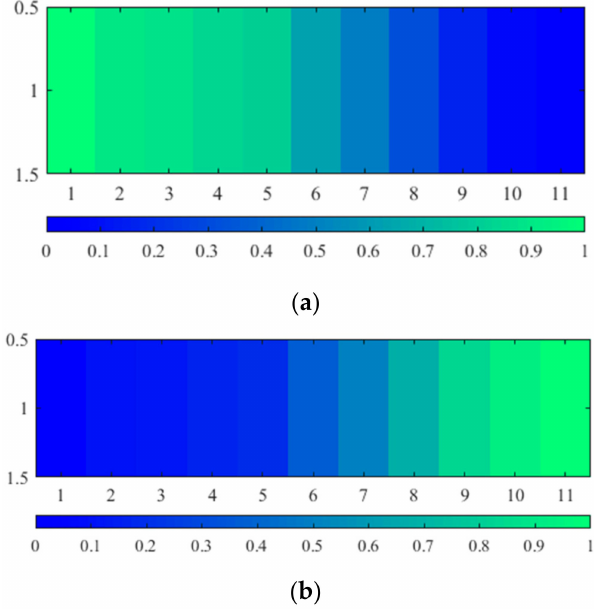
Figure 11. Quantitative distribution diagram of energy density: ( a ) 6 mm side amplitude quantization distribution diagram; ( b ) 10 mm side amplitude quantization distribution